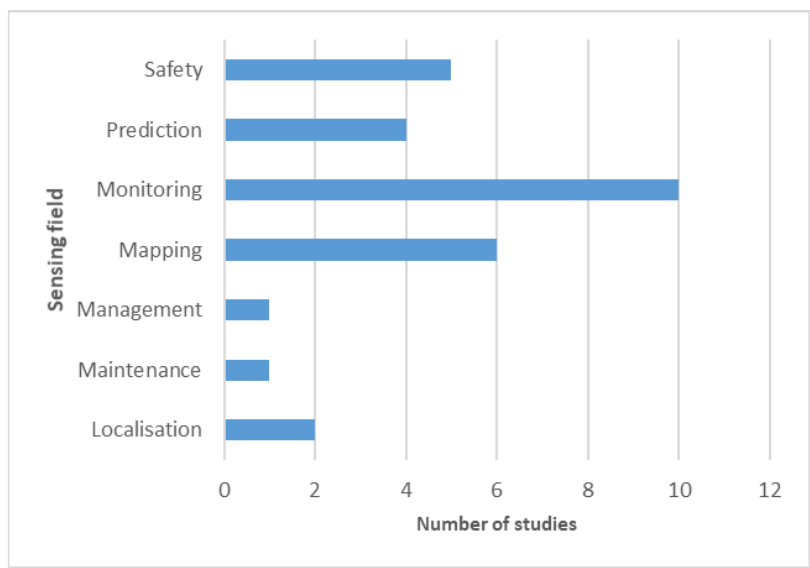
Figure 4. Study distribution per sub-process.